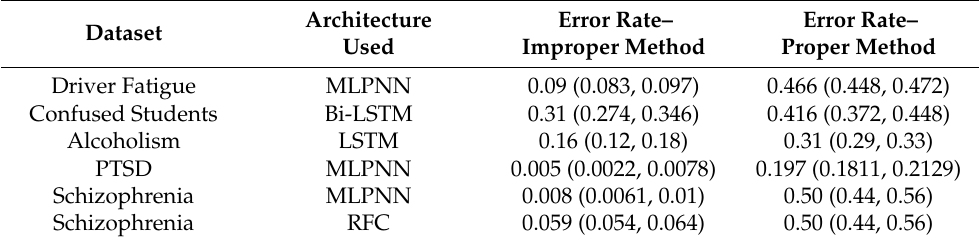
Table 3. Validation results for the five case studies (95% CI). All datasets are binary classification tasks, and all datasets are balanced except for the Alcoholism dataset. This gives chance error rate for Alcoholism defined as 0.36, and 0.50 for all other datasets. Results should be compared within datasets (left to right) between the improper and proper method. The proper method always reveals a significantly greater error rate than the improper method, suggesting the risks of overestimation of performance, which can result from using the improper